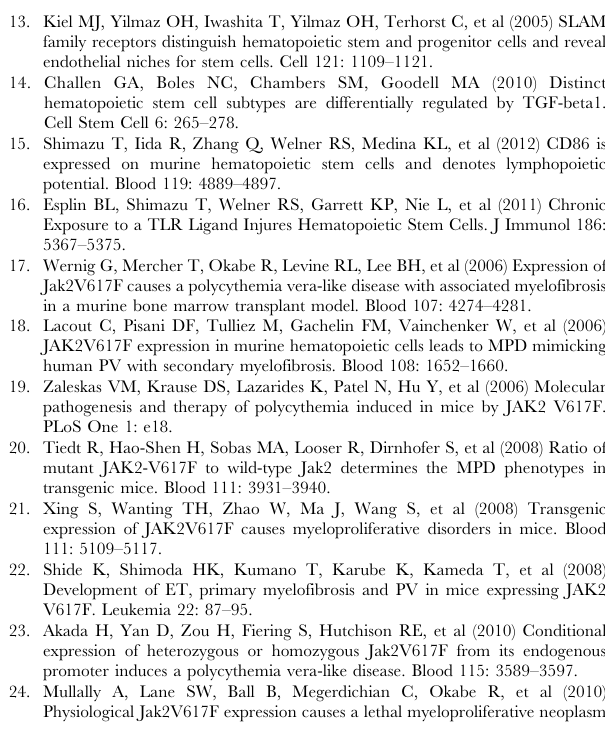
Figure S1 HSC differentially express other markers that can be used to monitor HSC subsets in JAK2V617F mice. ( A, B, D, E ) CD48 2 LSK were gated and characterized with CD18, CD41, VCAM-1 and CD39 in the CD150 Hi fraction. ( C ) Altered ratios of CD86 2 CD41 + and CD86 + CD41 2 were found in the CD150 Hi HSC fraction. CD150 + CD48 2 LSK were resolved with CD86 and CD41. (PDF) Figure S2 Lineage associated transcripts in lymphoid and erythroid progenitors. Real-Time PCR was performed using cDNA from sorted Flk2 + LSK and Lin 2 ckit Hi Sca1 2 CD150 + CD105 + pre-CFUE. The data are representative of those obtained in two independent experiments.